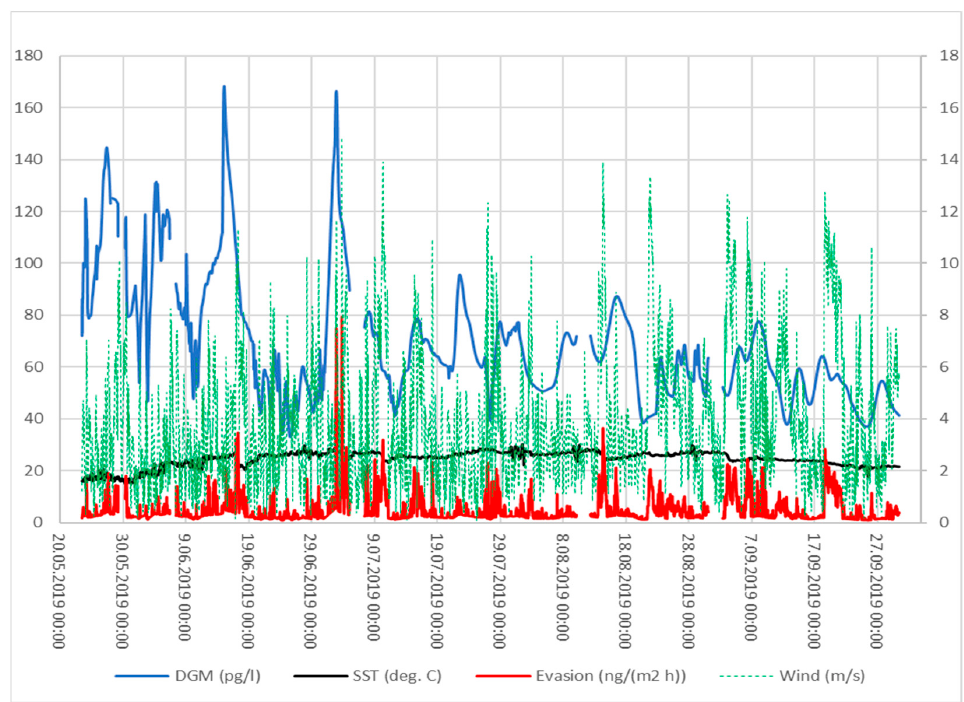
Figure 7. Hg 0 evasion and the measured input parameters over the period 23 May–30 September 2019. Secondary axis depicts the wind speed.